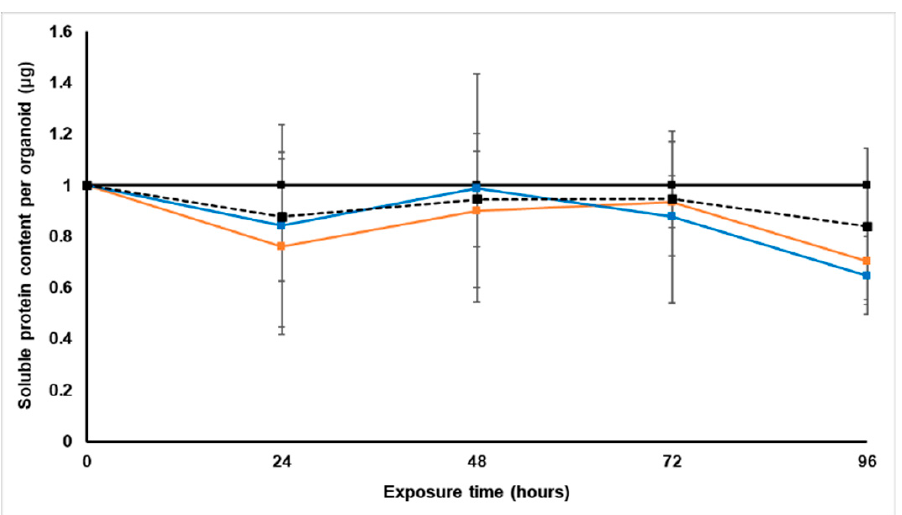
Figure 6. Normalized soluble protein content per spheroid ( µ g) of the sodium alginate encapsulated LS180 mini-tumor model, following 96 h exposure to Xysmalobium undulatum aqueous extract or paclitaxel. The solid black line represents the untreated control, the black dashed line represents paclitaxel [IC 50 ], the orange line represents X. undulatum [IC 50 ] and the blue line X. undulatum 2[IC 50 ]. All data were normalized to the untreated control group (error bars = standard deviation, n = 6). The total soluble protein content per bioreactor was used as for the S. frutescens treat- ment, to calculate the daily dose for each treatment group based on the number of